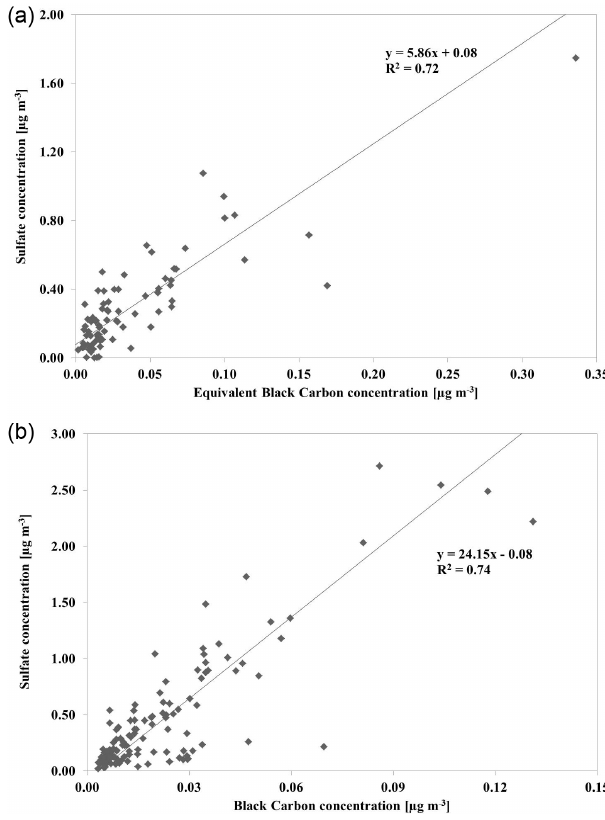
Figure 4. Scatter plot of EBC/BC and sulfate concentrations based on (a) measurement results (the slope obtained by orthogonal re- gression between sulfate and EBC is y = 5.86 showing a correlation coefficient of R 2 = 0.72) and (b) model results (the slope obtained by orthogonal regression between sulfate and BC is y = 24.15 showing a correlation coefficient of R 2 = 0.74) during May 2011 to August 2013 at VRS (Station Nord), North